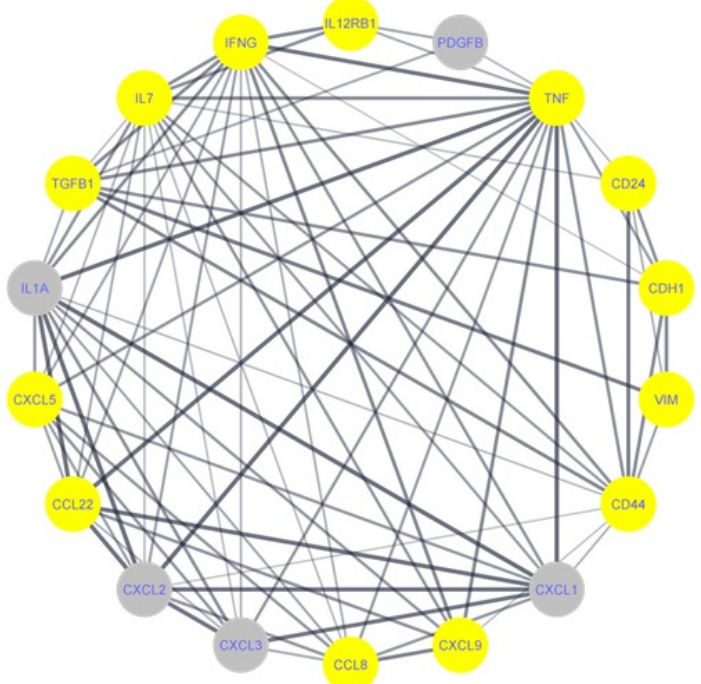
Figure 5. PPI network of WF cytokine array with m-RNA data from the WF-treated cell lines, MDA-MB-231 and Sum-149. Nodes represent all upregulated cytokines in WHF of both non-IBC and IBC cell lines, mRNA of CD24 and CD44 as cancer stem cell markers, and vimentin and E-cadherin as epithelial mesenchymal transition markers. We focused on GRO (CXCL1, CXCL2, CXCL3), IL-1 α , IL-7, and PDGF-BB, which are marked with the grey color, and their interaction with biomarkers of stem cell and mesenchymal transition process.